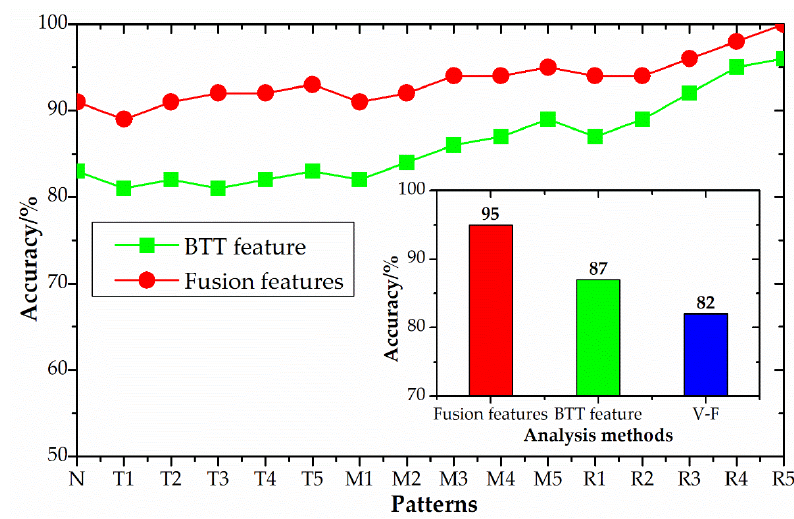
Figure 11. Comparison of diagnostic results with different methods.